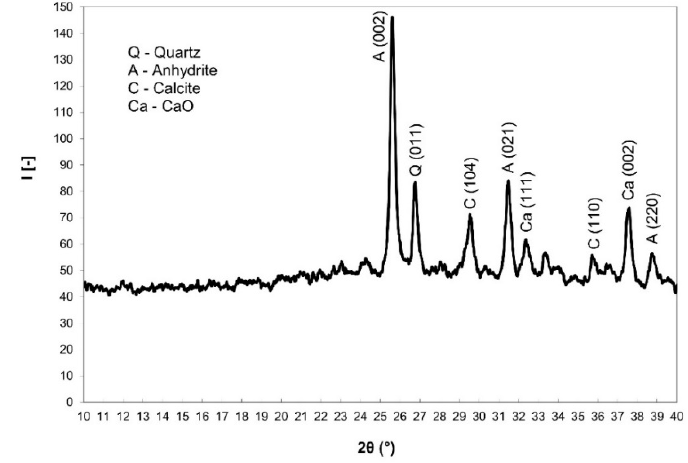
Figure 1. Mineralogical composition of the used CCFA (CCFA-H) via XRD patterns. Figure 2a,b represents the microstructure of the used CCFA. The anhydrite crystal Table 4. Crystallographic parameters of identified minerals in CCFA. can be seen in Figure 2b marked with letter A, the other fine particles were located in clusters and contained quartz, hematite, calcite, and amorphous aluminosilicate particles.